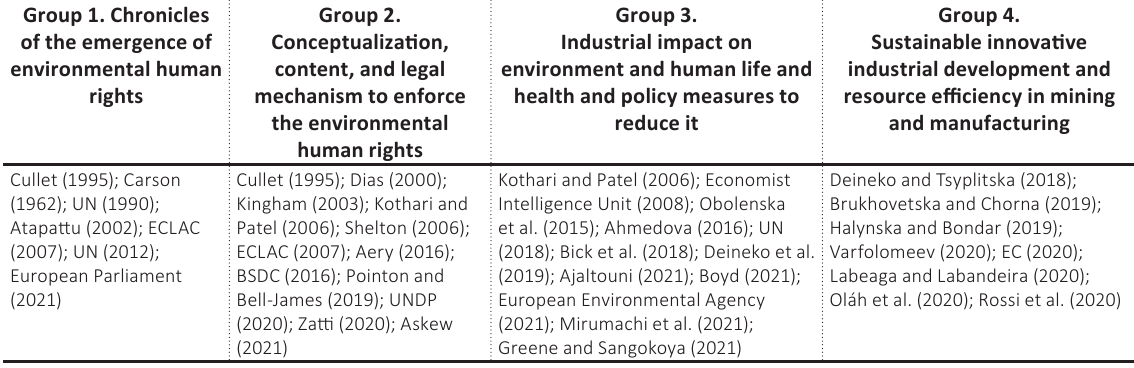
Table 1. Grouping the literature sources by the focus of a study